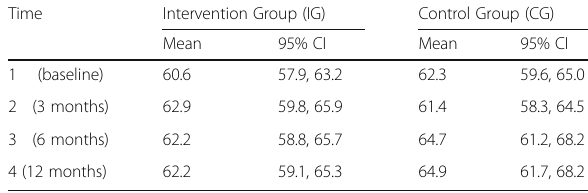
Table 1 (abstract 000500). Estimated means dependent variable: Total Sense of coherence (SOC)